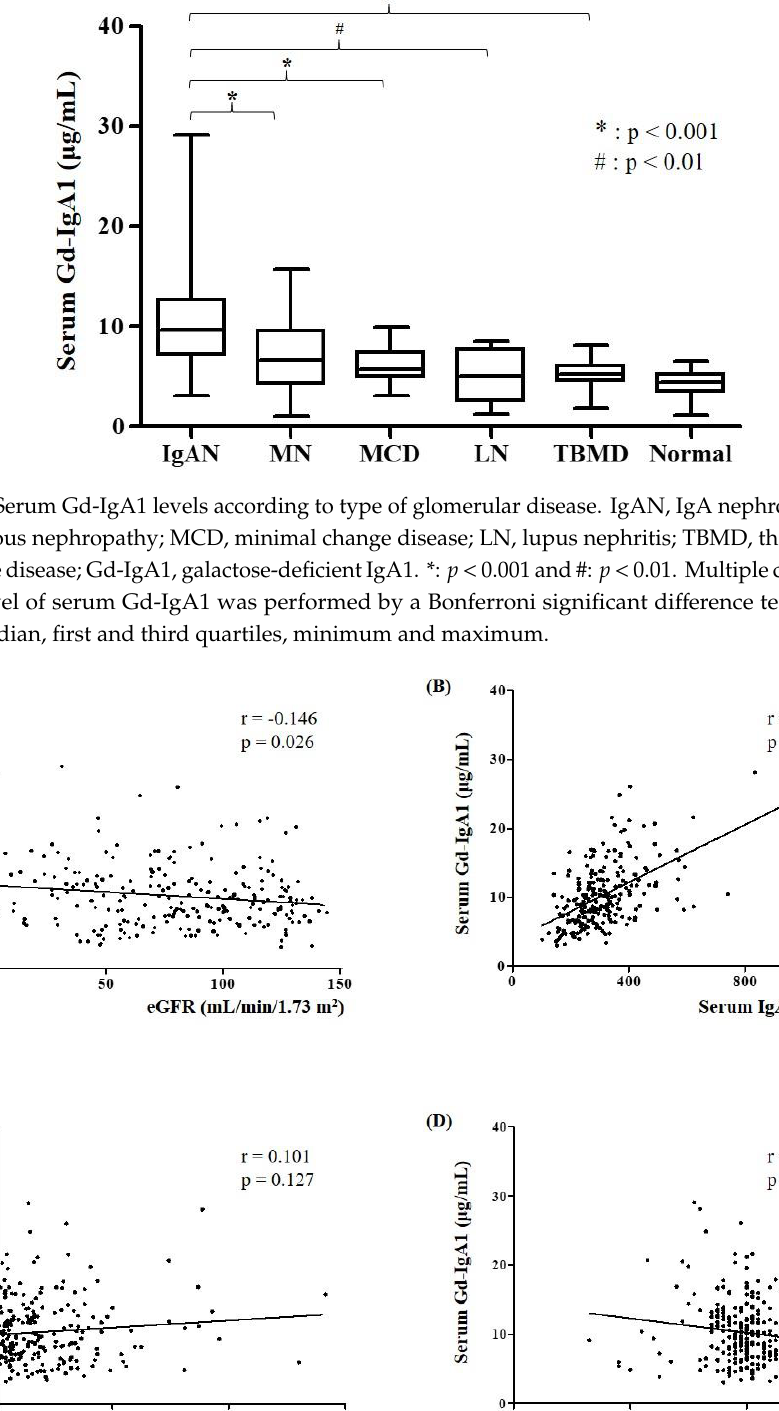
Figure 1. Serum Gd-IgA1 levels according to type of glomerular disease. IgAN, IgA nephropathy; MN, membranous nephropathy; MCD, minimal change disease; LN, lupus nephritis; TBMD, thin basement membrane disease; Gd-IgA1, galactose-deficient IgA1. *: p < 0.001 and #: p < 0.01. Multiple comparisons for the level of serum Gd-IgA1 was performed by a Bonferroni significant difference test. Box plot shows median, first and third quartiles, minimum and maximum.